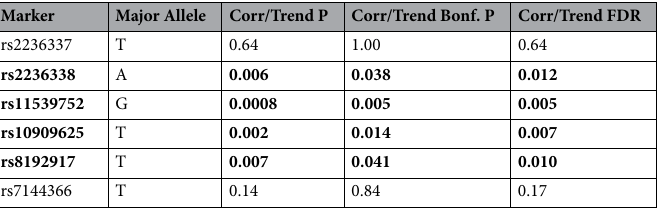
Table 2. Multiple testing correction using false discovery rate. Bold numbers indicate significant